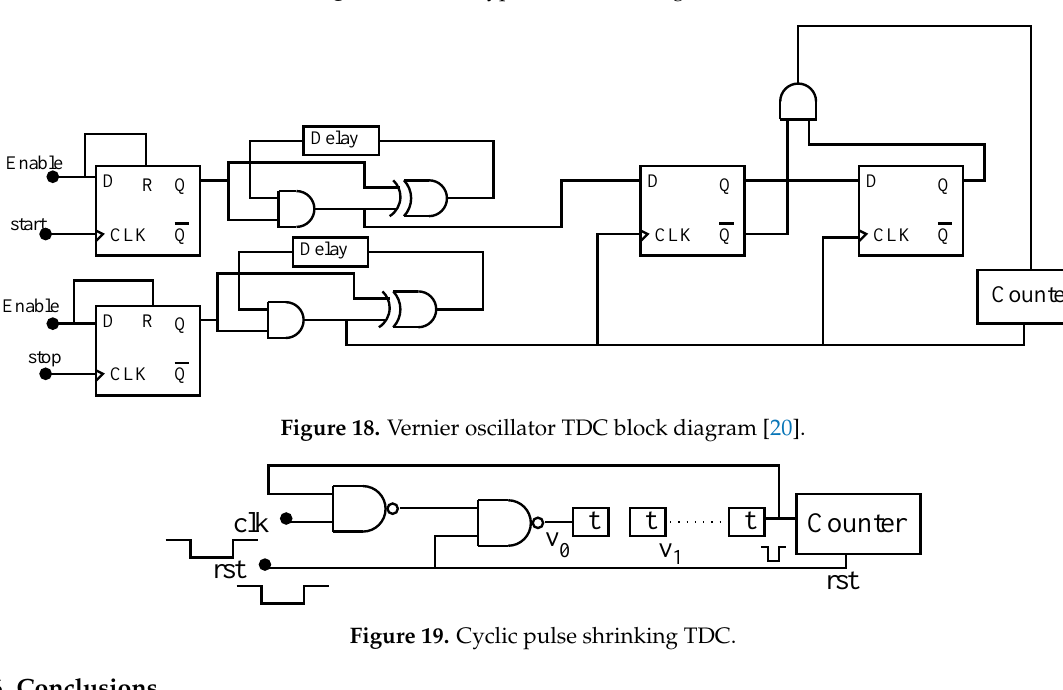
Figure 17. Flash-type TDC block diagram [18].